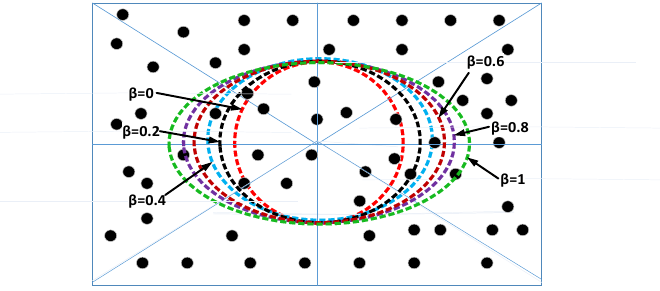
Figure 6. Different values of β for different trajectories of the AUV.